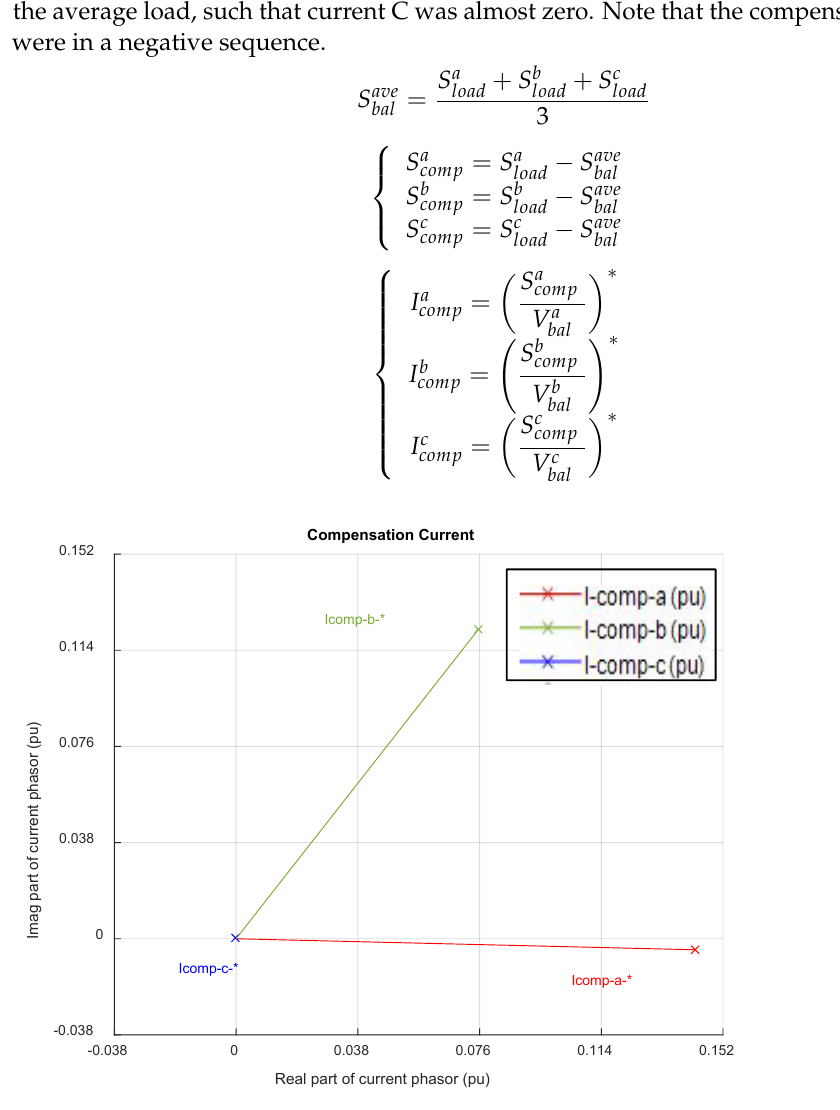
the average load, such that current C was almost zero. Note that the compensation currents were in a negative sequence.